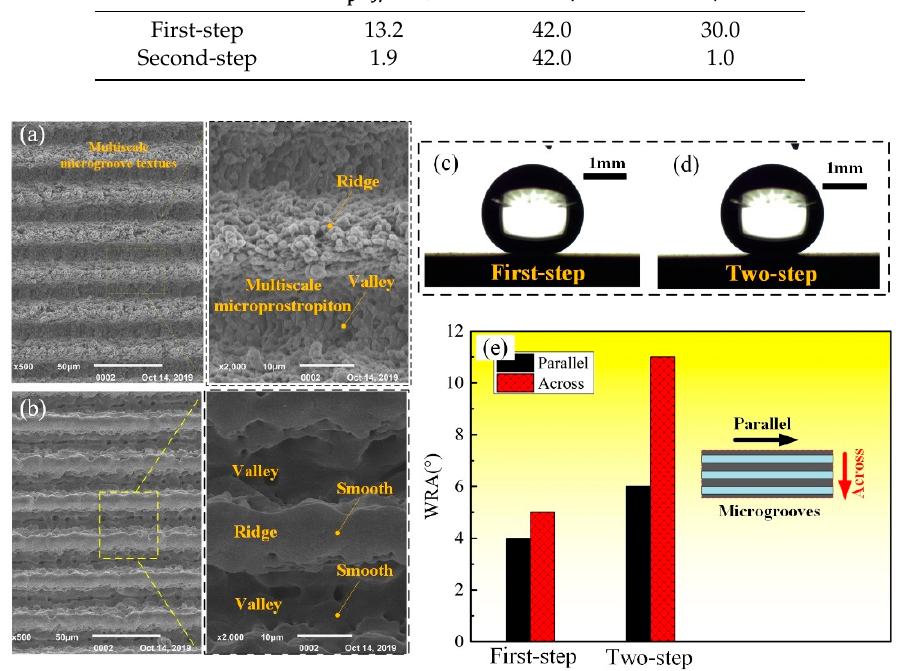
Figure 16. SEM morphology of microgroove textures obtained by ( a ) first-step and ( b ) two-step laser-scanning irradiation with the parameters listed in Table 2; Photographs for WCA measurement of the anterior-mentioned ( c ) first-step and ( d ) two-step laser-irradiated surfaces after silanization; ( e ) WRAs along the directions parallel to and across the microgrooves of the first and single-scale microgroove textures. Table 2. Laser parameters applied for fabricating the microgroove textures shown in Figure 16.